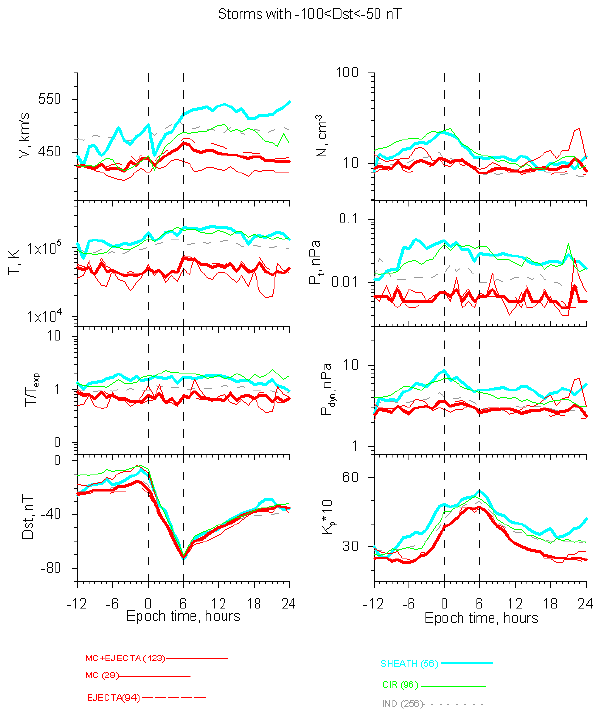
Fig. 3. The same as in Fig.1 for moderate storms with -100 < Dst < -50 nT.